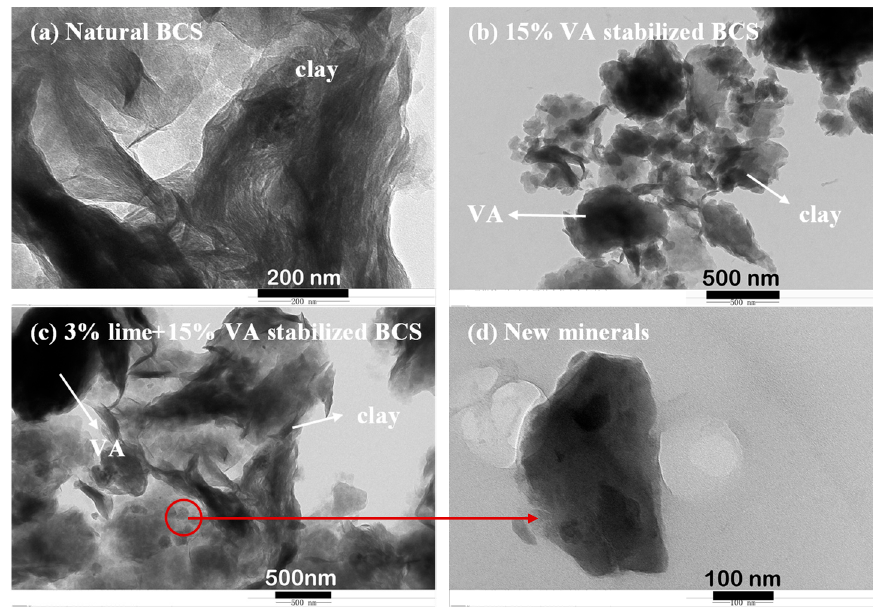
Figure 9. TEM images of stabilized soil samples.